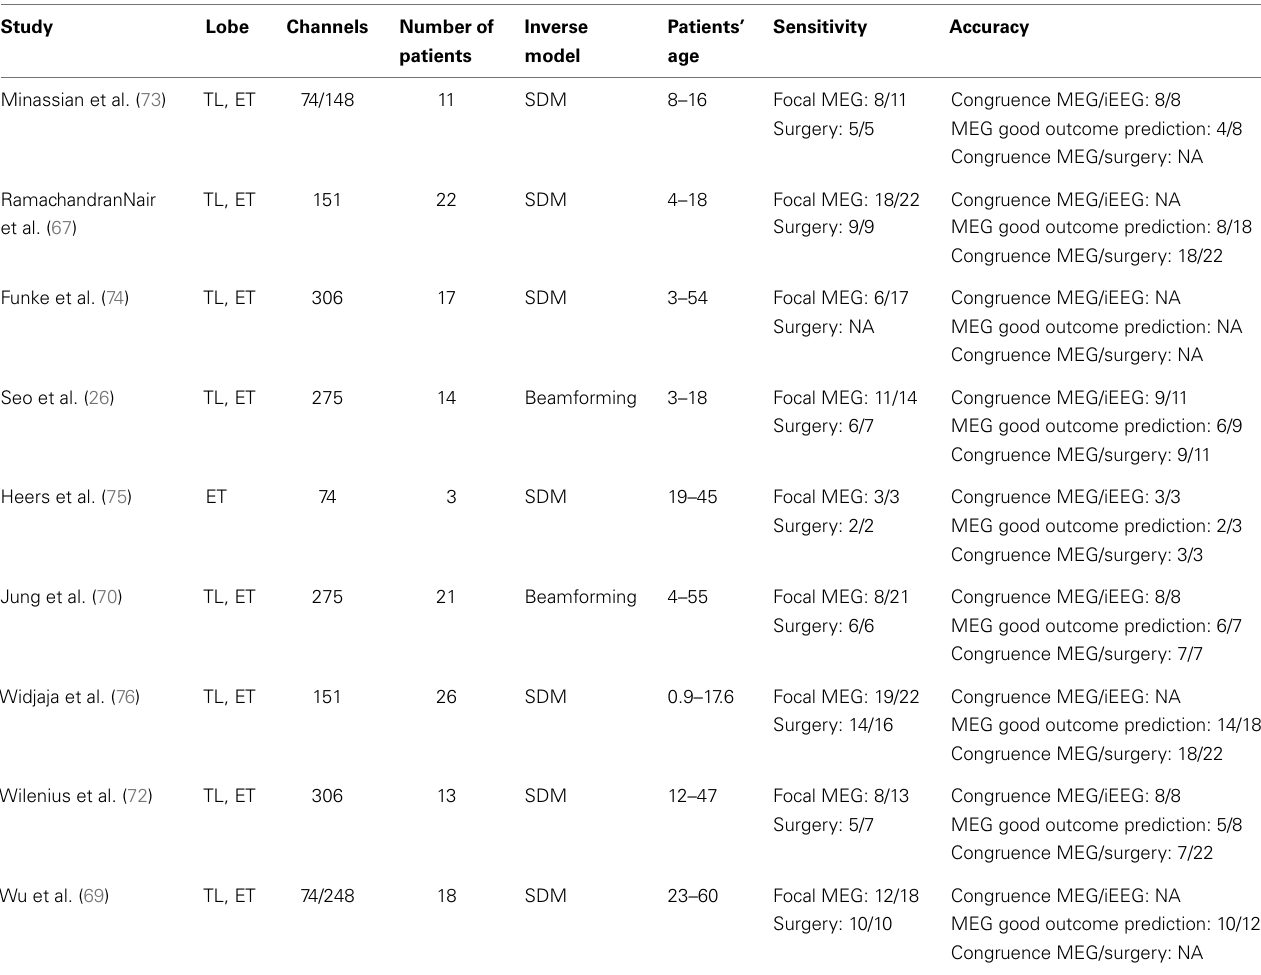
Table 2 | Diagnostic accuracy of MSI in MRI-negative focal